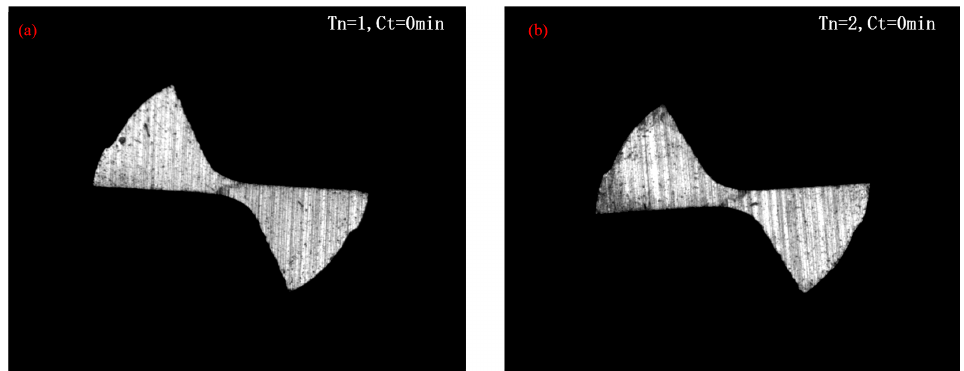
Figure 5. Original images of micro end milling tools:( a ) original image of No.1 tool;( b ) original image of No.2 tool.